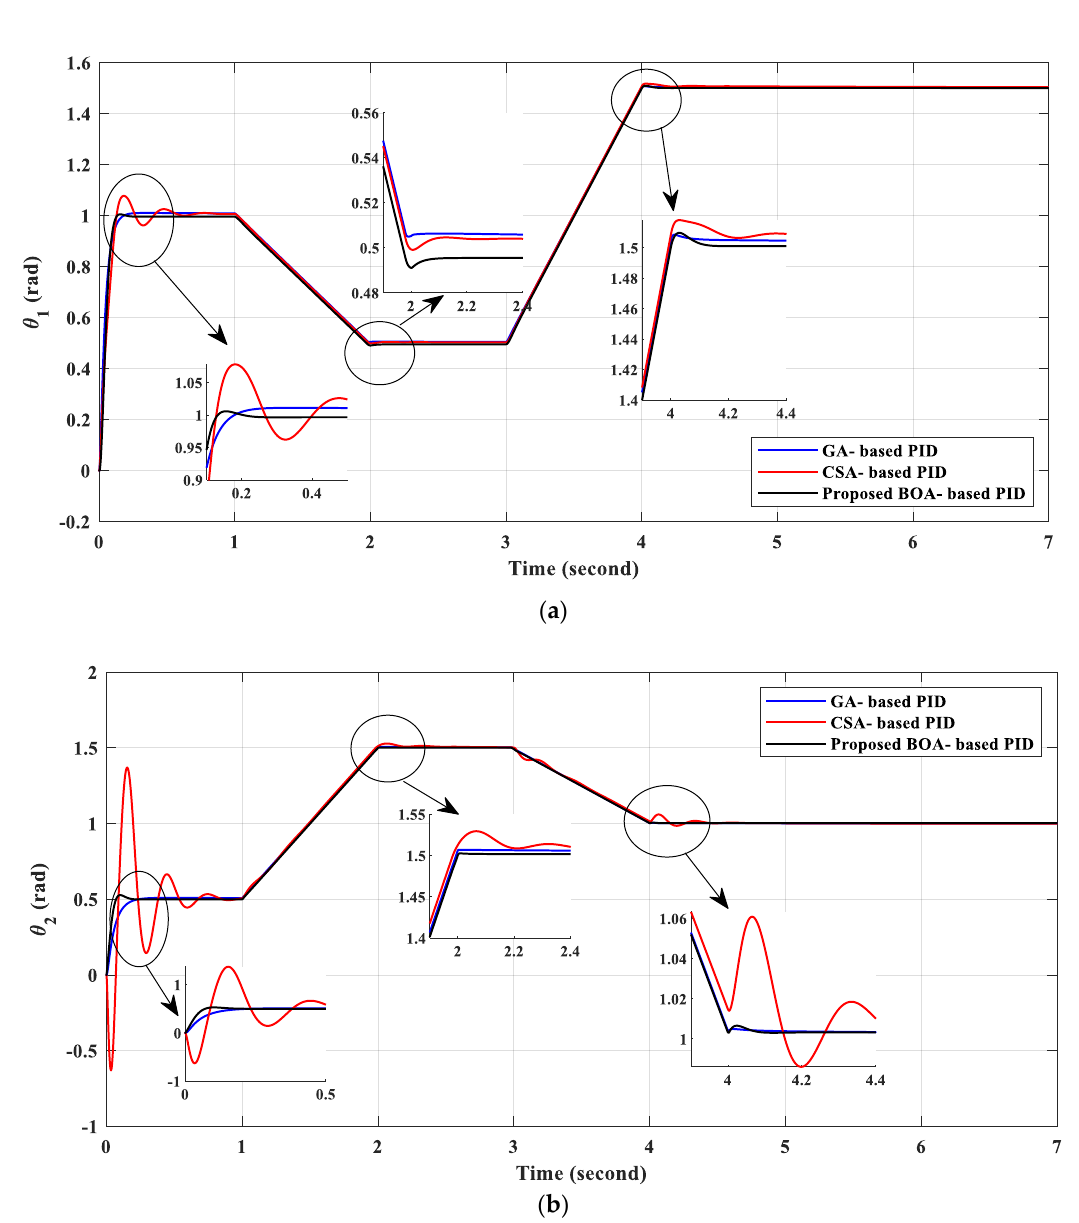
Figure 14. The link 1 output wave of as a result of random step-position trajectories; ( a ) link 1 position ( b ) link 1 position deviation.